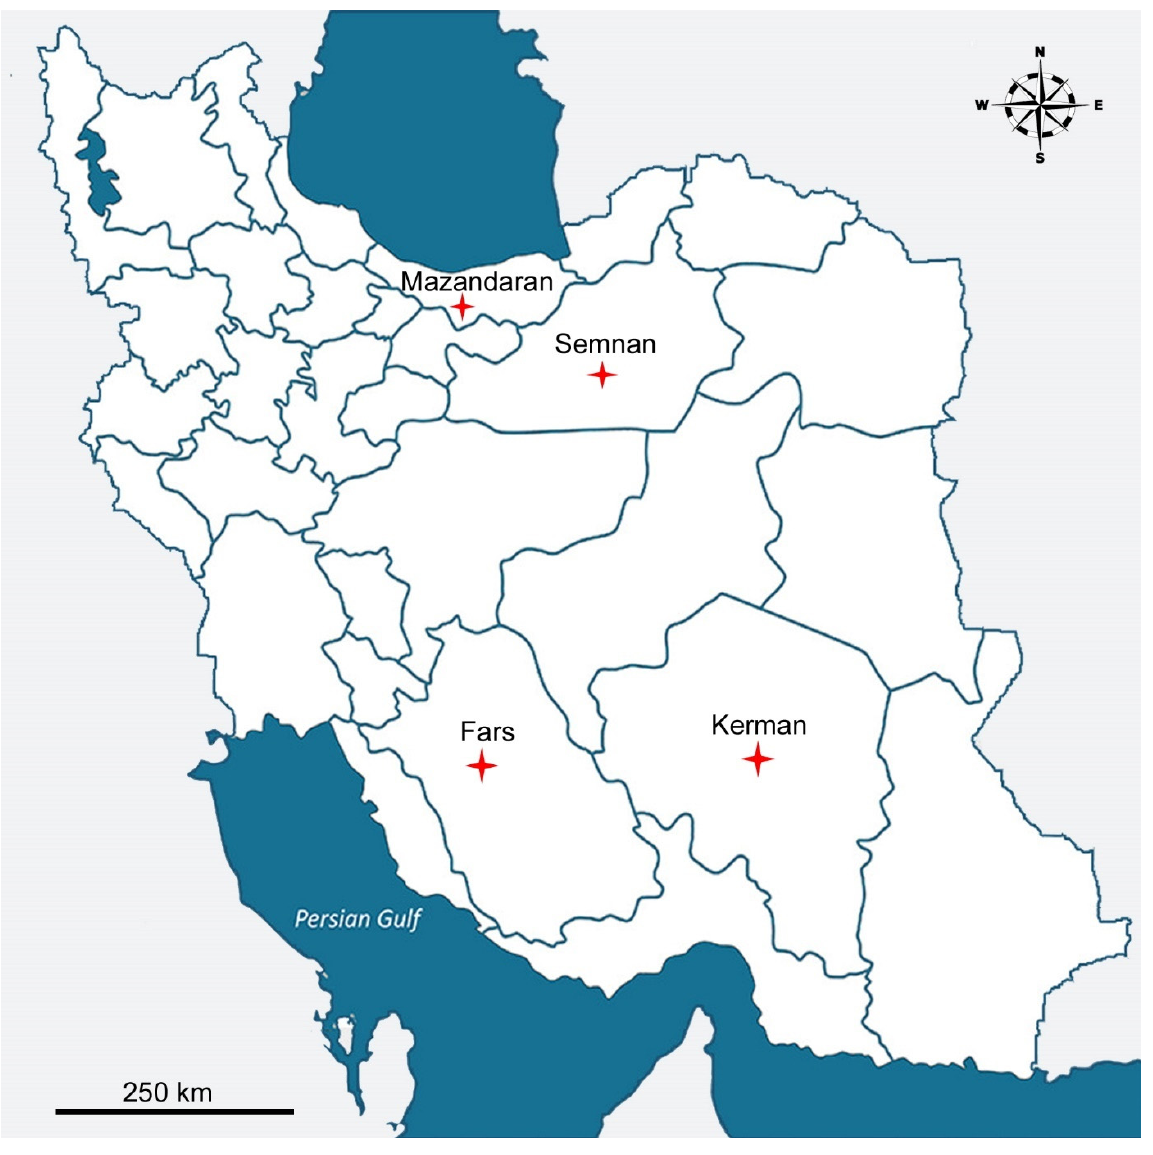
Figure 1. Localities of the sampling (red star) for Mylonchulus species in Iran.